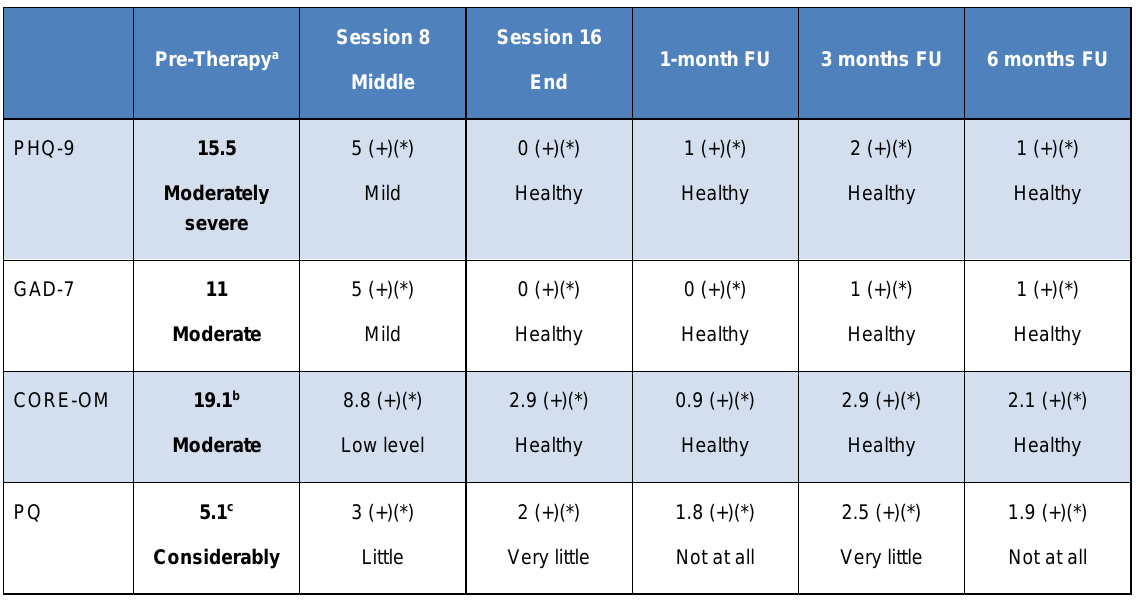
Table 1: Margherita’s Quantitative Outcome Measure